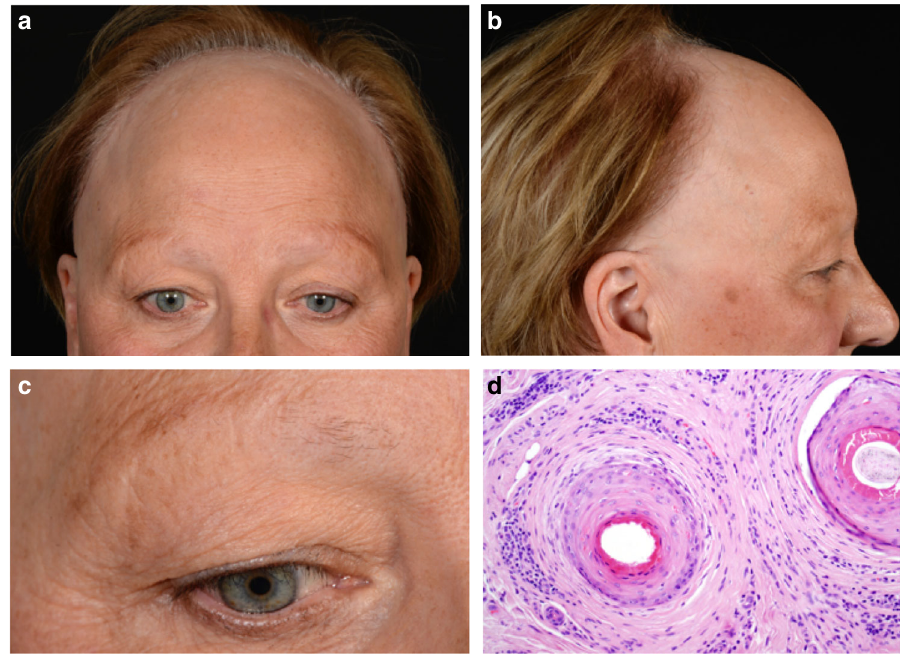
Fig. 1 Clinical features of frontal fi brosing alopecia. Scalp with frontal hairline recession ( a ) involving the temporal areas bilaterally ( b ), as well as eyebrows ( c ). Histopathology ( d ) shows two hair follicles with focal interface changes, and a moderately dense perifollicular lymphoid cell in fi ltrate with perifollicular fi brosis, characteristic of FFA